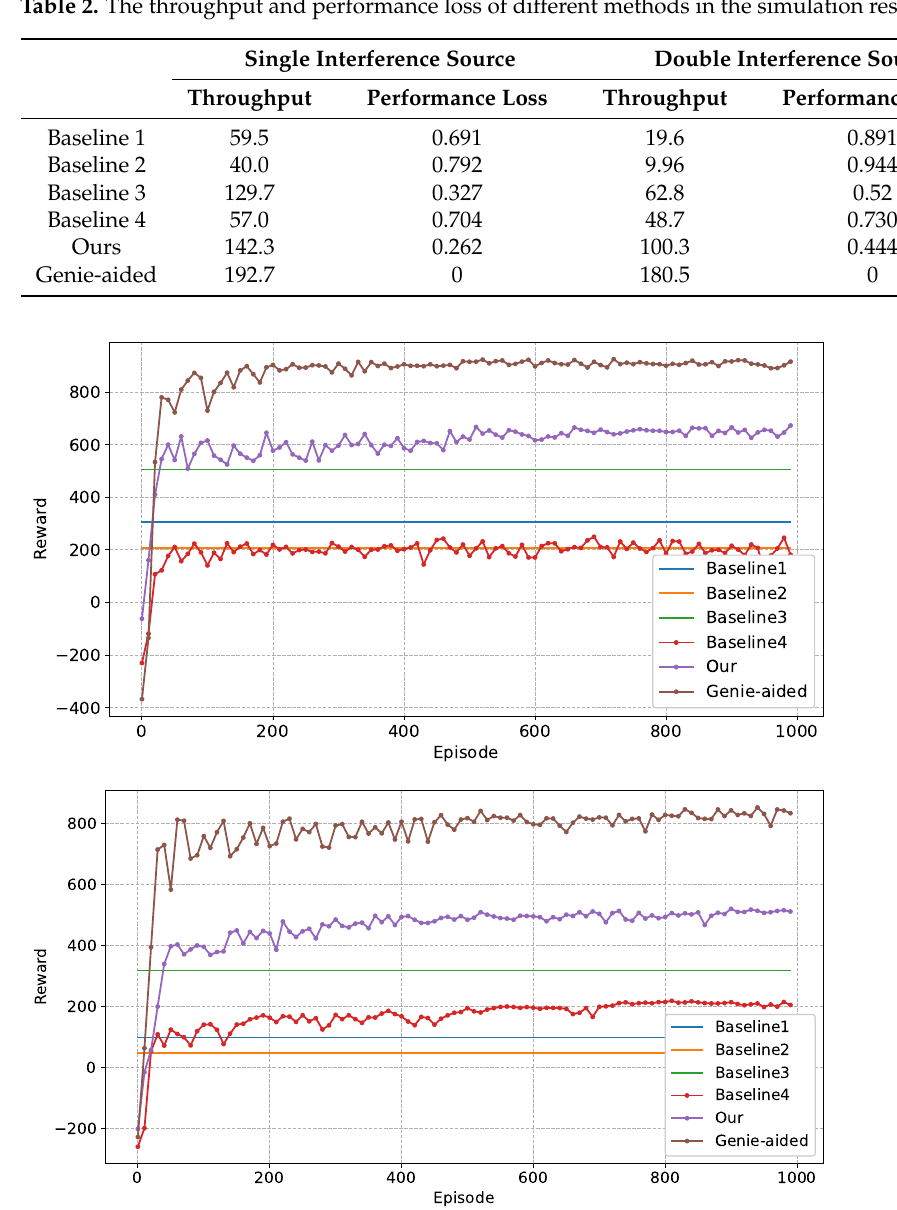
Figure 4. Reward convergence of the DQN method for the numerical result and the comparison of reward among different methods. The top is for single interference source, the bottom is for double interference